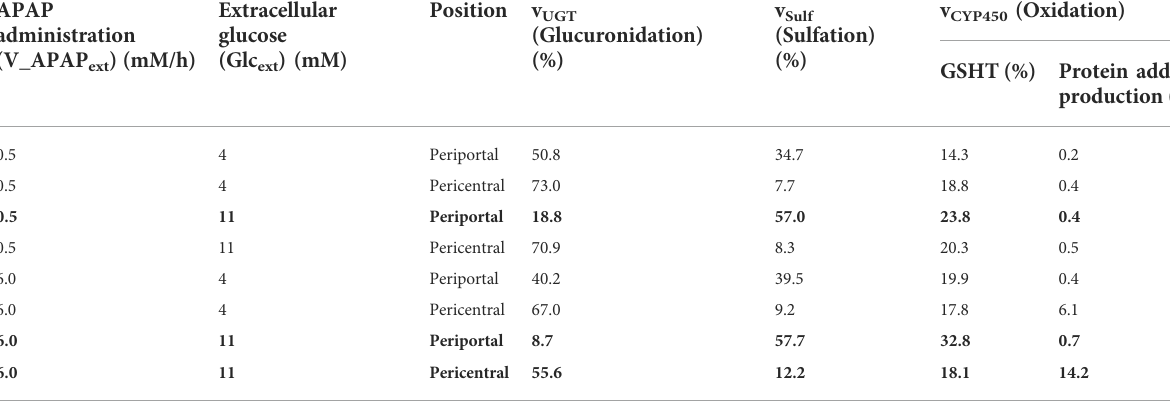
TABLE 3 Relative contribution of APAP metabolic pathways in healthy